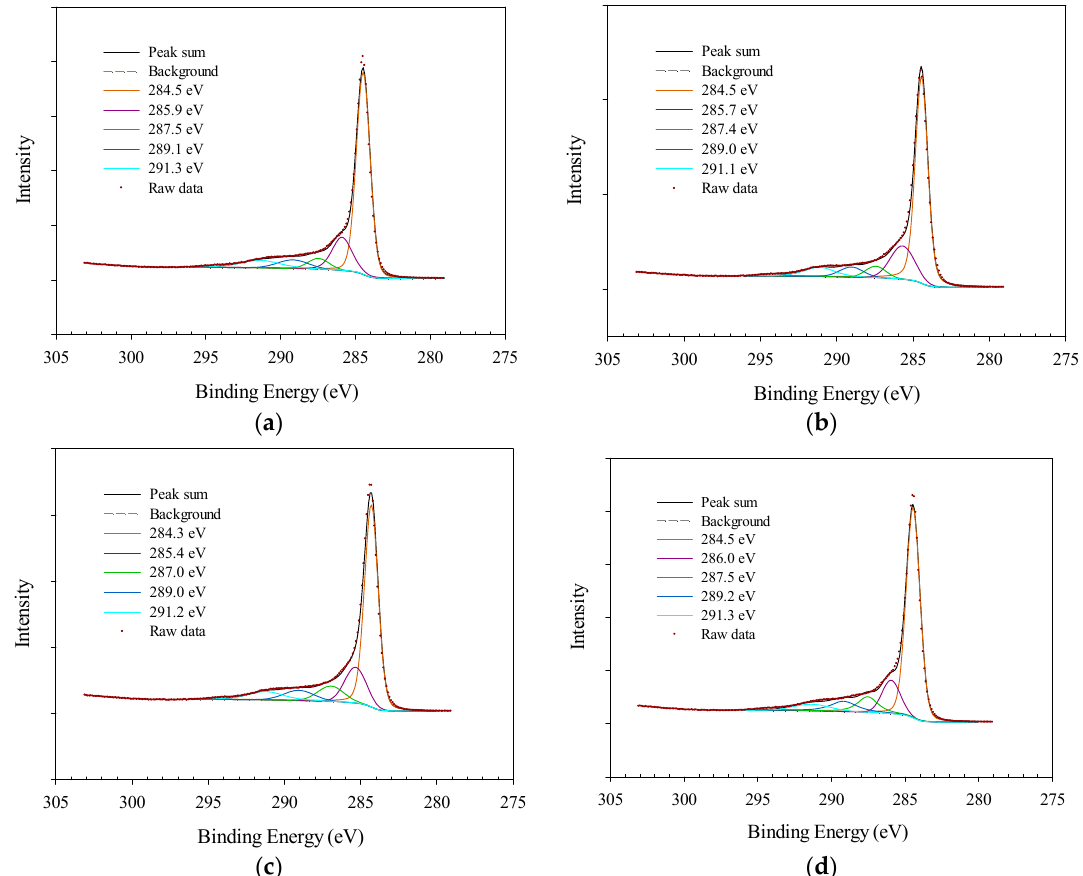
Figure 6. XPS spectra of carbon 1s peak for different AF 5 treatments ( a ) Water-treated ( b ) Hydrochloric acid-treated, ( c ) Sulfuric acid-treated, ( d ) Nitric acid-treated. Table 4. Relative concentration of di ff erent groups in C 1s